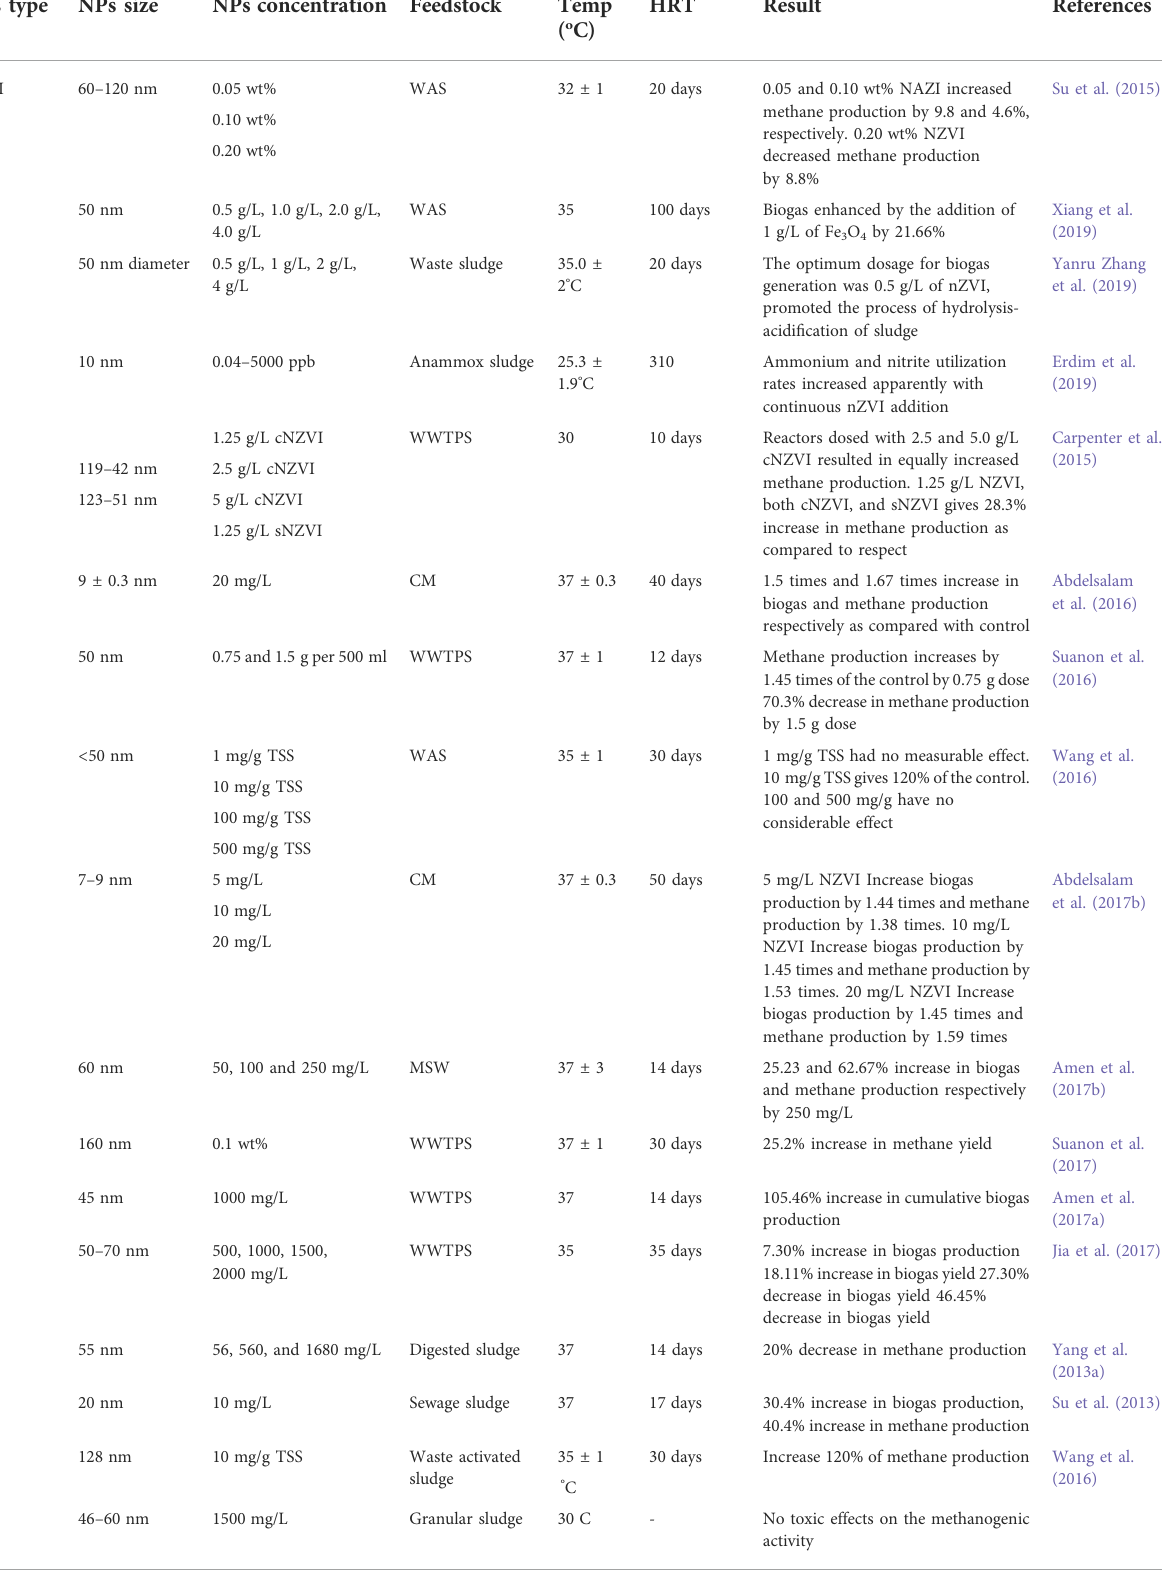
TABLE 2 Reported metal NPS and their in fl uence on biogas